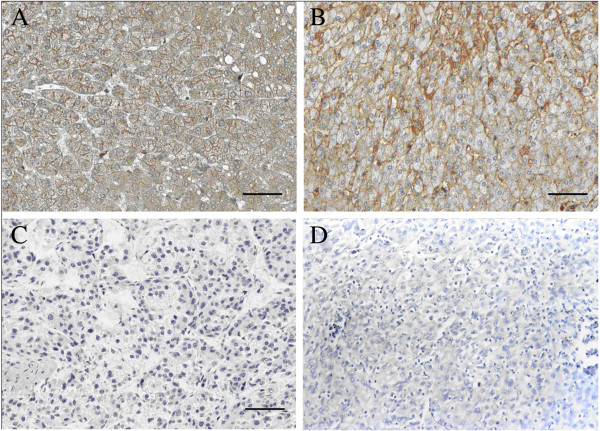
Immunohistochemistry (IHC) of the ferroportin expression in hepatocellular carcinoma (HCC) tissue sections (100 bp). A) Normal liver tissue cytoplasm and cell membrane presented positive ferroportin staining. B) Para-cancer liver tissues (PCLT) cytoplasm and cell membrane presented positive ferroportin staining. C) and D) Ferroportin positive staining has not been found in HCC tissue sections. A brownish black staining or brown orange staining shows ferroportin positive staining.